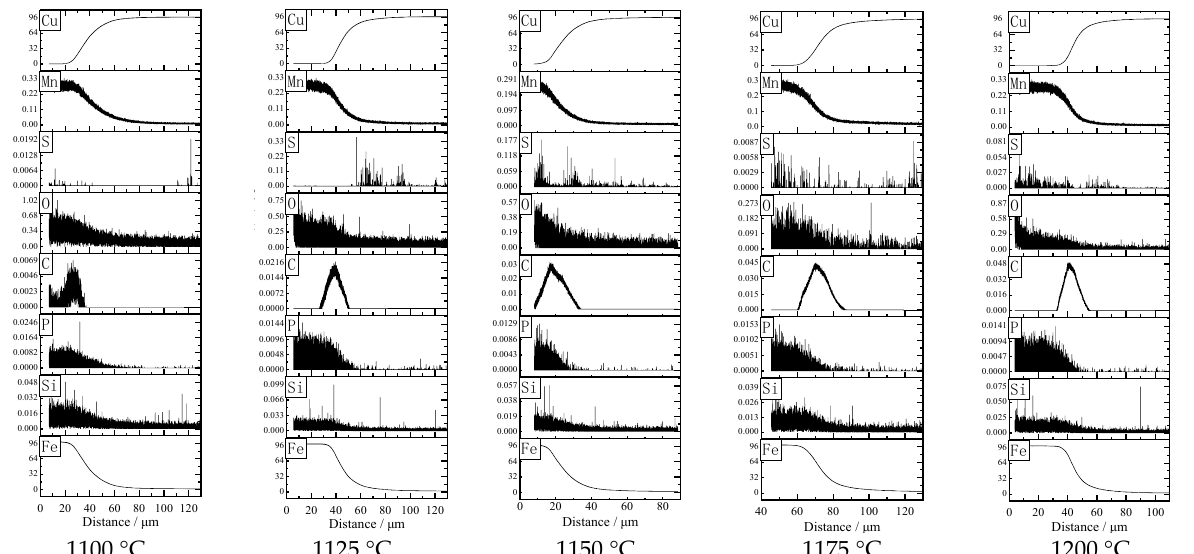
Figure 11. The elements distribution of the transition layer at different temperatures. As shown in Figure 11, for the element P, it mainly exists in low carbon steel. How ‐ ever, the P content near the copper/steel interface now is significantly higher than it in the steel before. This means that, as an easy segregation element, P has obviously diffused and segregated to the high temperature area. As the temperature rises, the diffusion amount of P into the copper begins to increase and then dissolves in the molten copper.